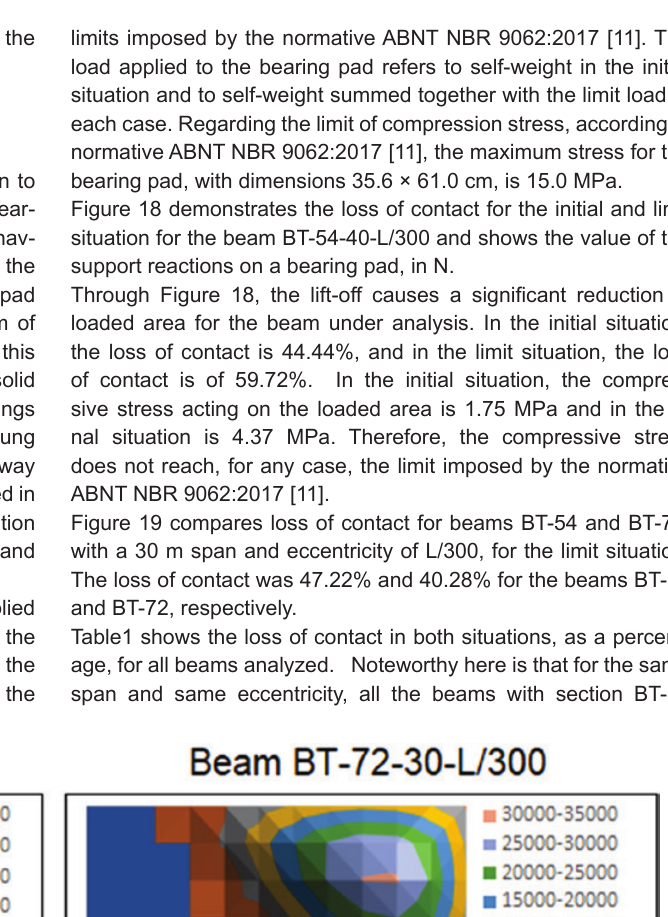
Lift-off of beam BT-54-40-L/300 onto the pad and reactions on springs (N)